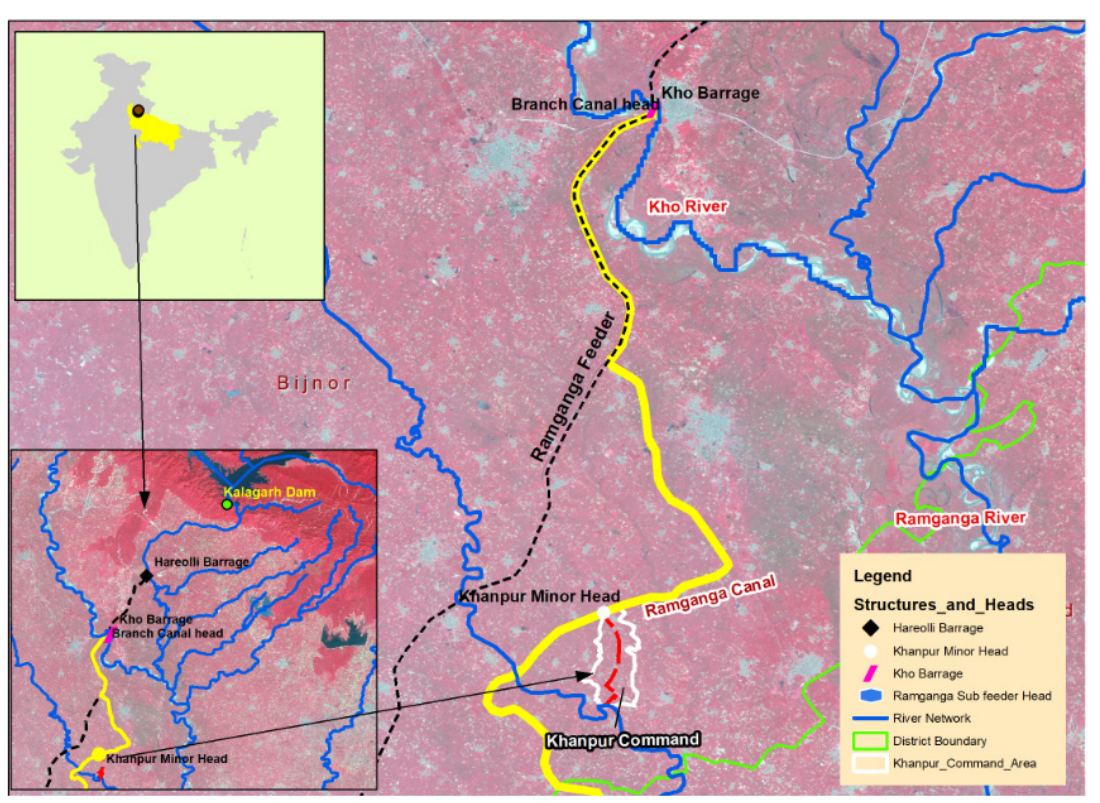
Figure 2. Location map of the Karula pilot area.